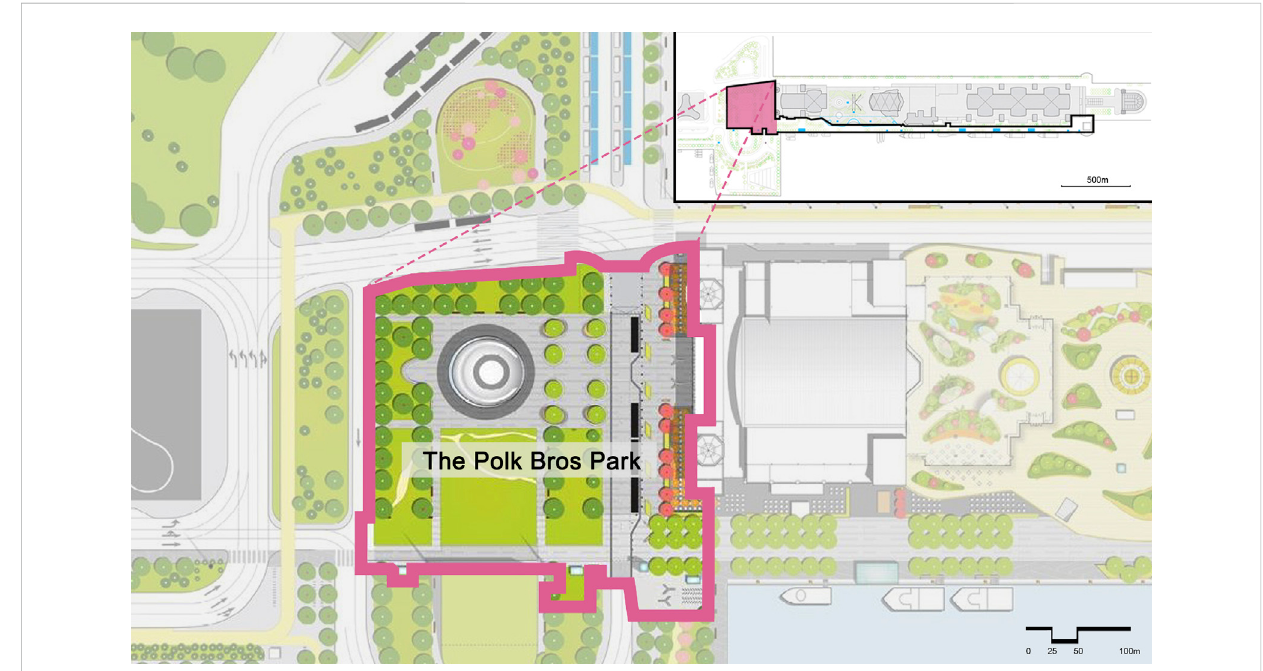
FIGURE 3 Suggestion of possible locations for bioswales in the boundaries of the SITES evaluation of the Chicago Navy